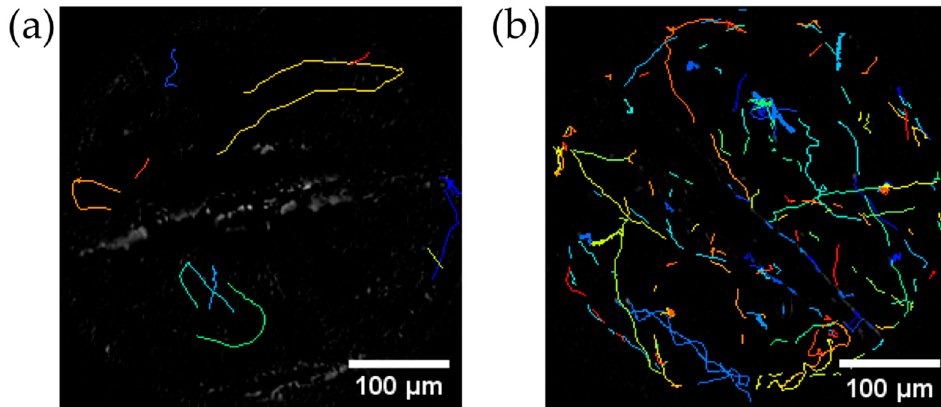
Figure 10. Trajectories of cell centers in C. reinhardtii for 11 s. ( a ) before stirring ( b ) immediately after 11-s stirring. Each color of the trajectory corresponds to each cell. The scale bars designate 5 μ m.